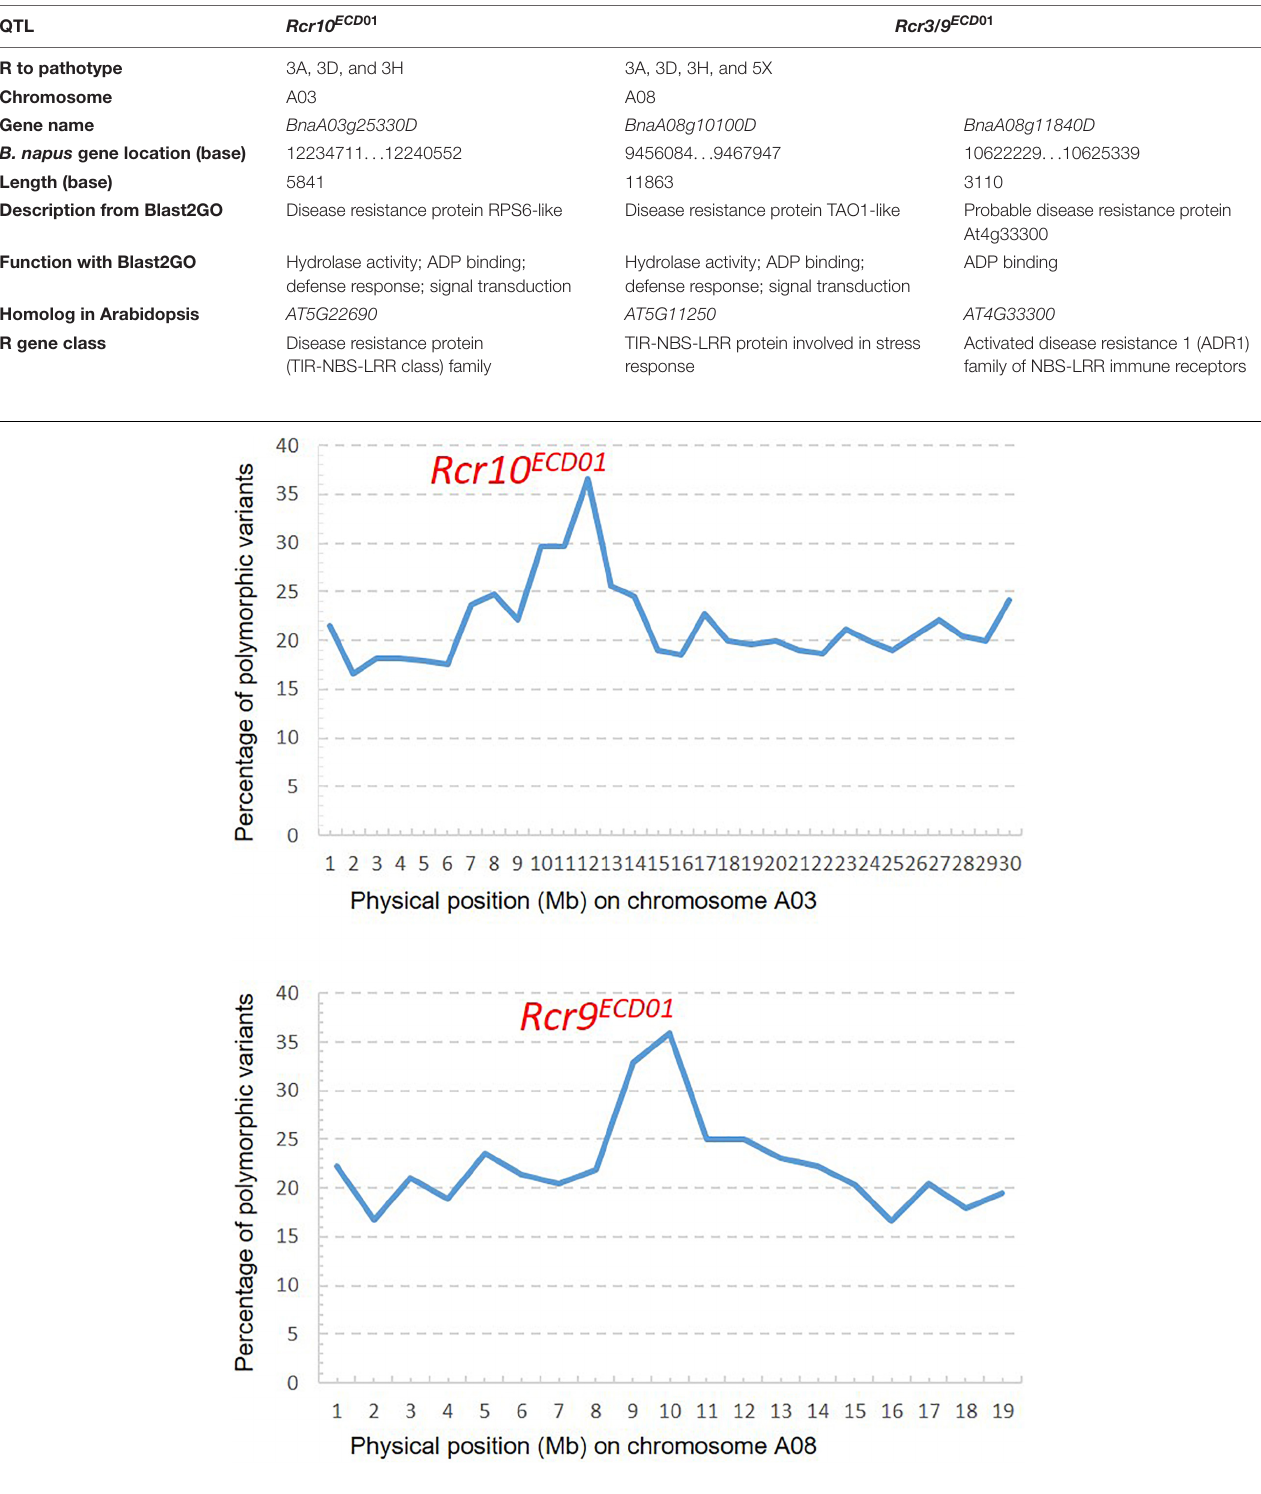
FIGURE 4 | Distribution of polymorphic variants (%): One peak for Rcr10 ECD 01 on chromosome A03 and the other for Rcr9 ECD 01 on A08 were identified through bulk segregant analysis with the mapping method of the percentage of polymorphic variants described by Yu et al. (2016) and Dakouri et al. (2018).